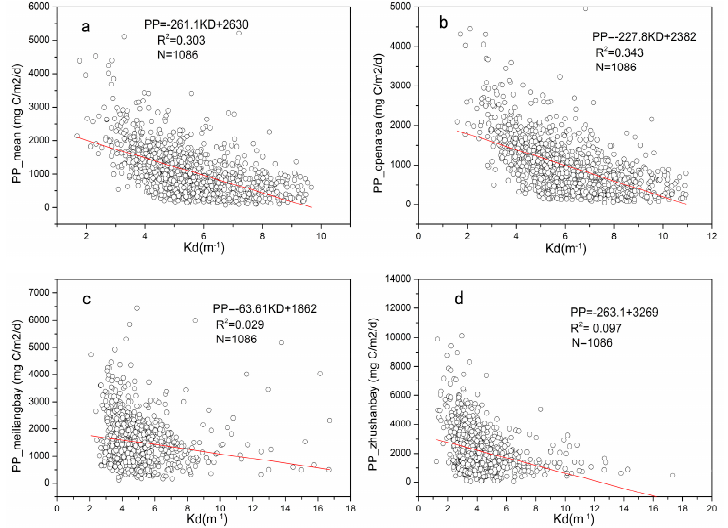
Figure12. Correlations between PAR diffuse attenuation coefficient and phytoplankton primary production for the regions of ( a ) the entire Lake Taihu; ( b ) the open area; ( c ) Meiliang Bay and ( d ) Zhushan Bay.